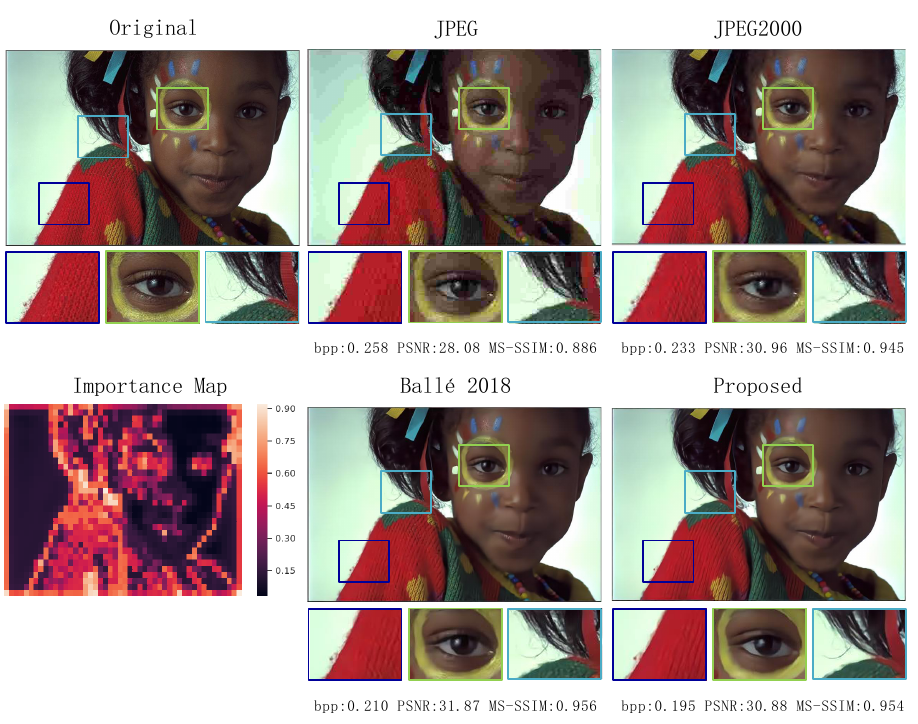
Figure 7. Visual quality evaluation of the specific image named kodim15 in Kodak dataset with different